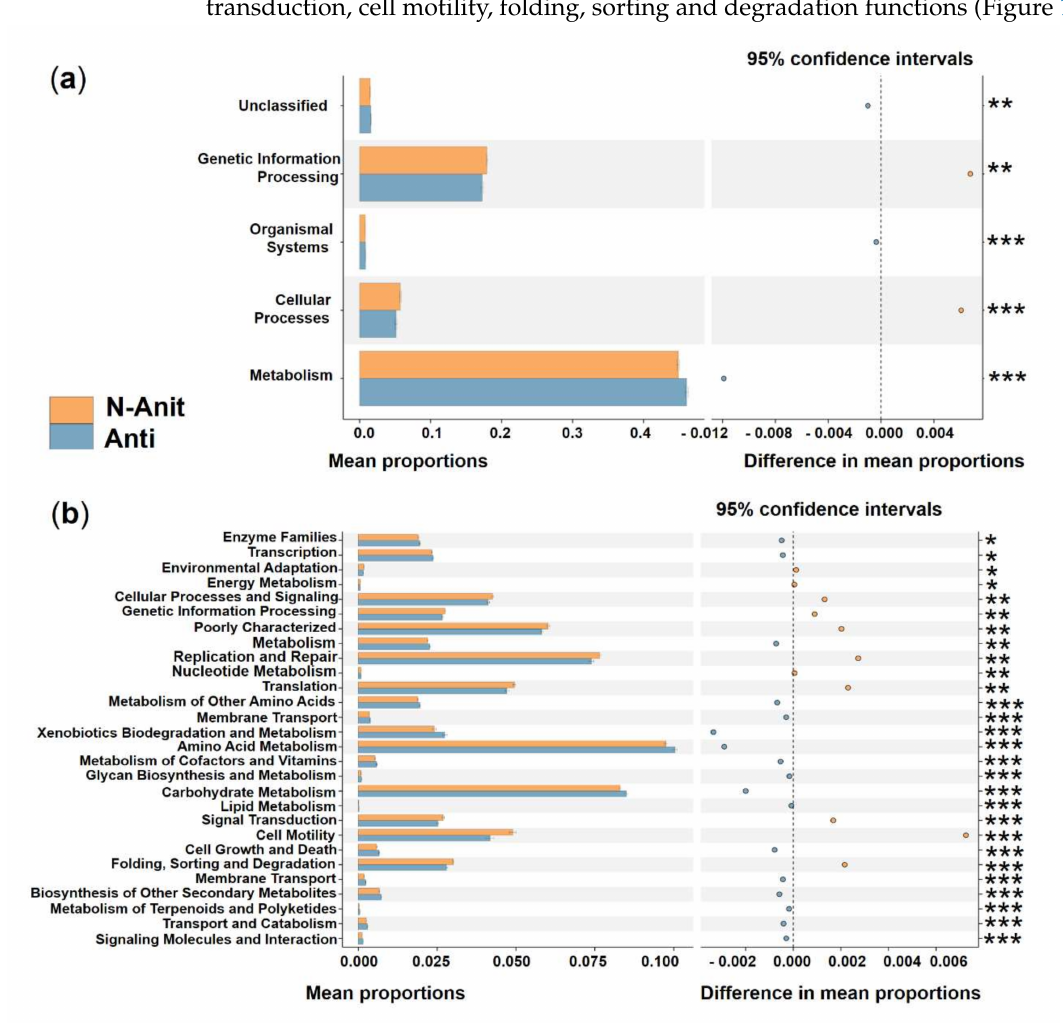
Figure 10. Prediction of the differential function of bacterial associations between the N − Anti (orange) and Anti (blue haze) groups in KEGG categories at level 1 ( a ) and level 2 ( b ). Gene functions were predicted from 16S rRNA gene-based microbial compositions using the PICRUSt algorithm to make inferences from KEGG annotated databases. Relative signal intensity was normalized by the number of the genes for each indicated metabolic pathway. *, **, *** indicate the difference is at a significant level with p < 0.05, p < 0.01, and p < 0.001,